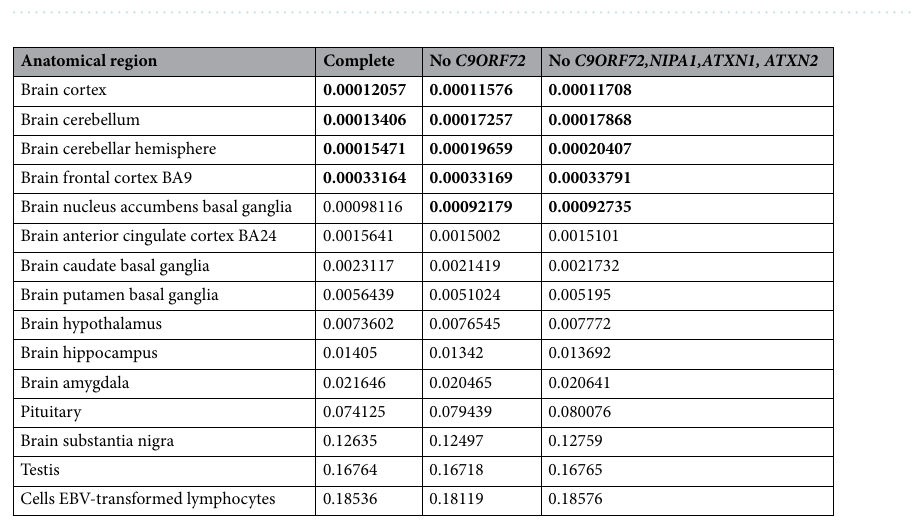
Table 1. P values for the most enriched tissues for MAGMA tissue enrichment analysis of candidate genes for ALS, based on GTEx RNA-seq data for 54 specific tissue types. Significant P values are bolded.